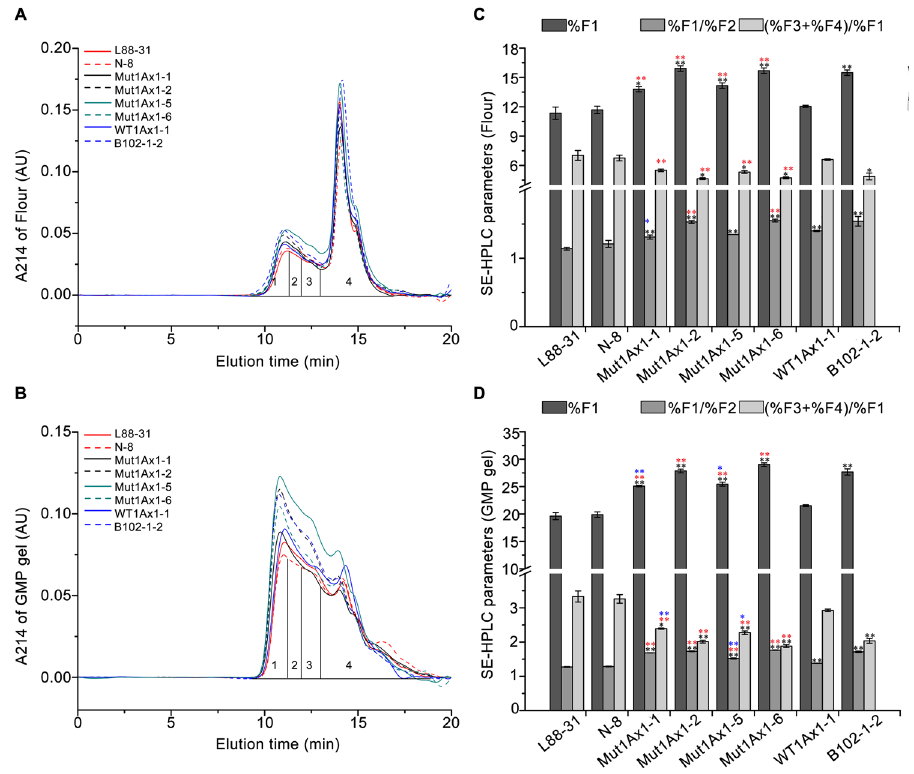
Figure 4. Effects of Mut1Ax1 on the formation of HMW aggregates. SE-HPLC analyses of flour and GMP gel samples of transgenic and control lines are shown in ( A ) and ( B ), with corresponding comparisons of three parameters (%F1, %F1/%F2, and (%F3 + %F4)/%F1) analysed statistically in ( C ) and ( D ). Bars represent the mean ± SEM (n = 4). * / ** show the comparisons between all transgenic lines and negative controls (L88-31 and N-8) on the three parameters above, while and represent comparisons between transgenic lines expressing mut1Ax1 and line WT1Ax1-1 and comparisons between those lines and line B102-1-2, respectively ( * P < 0.05, ** P < 0.01 by Student’s